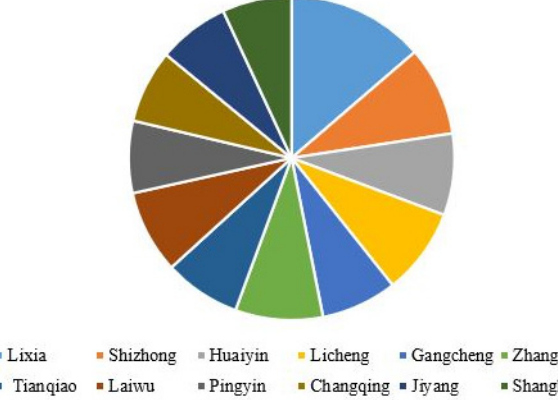
Figure 7. Regional weight